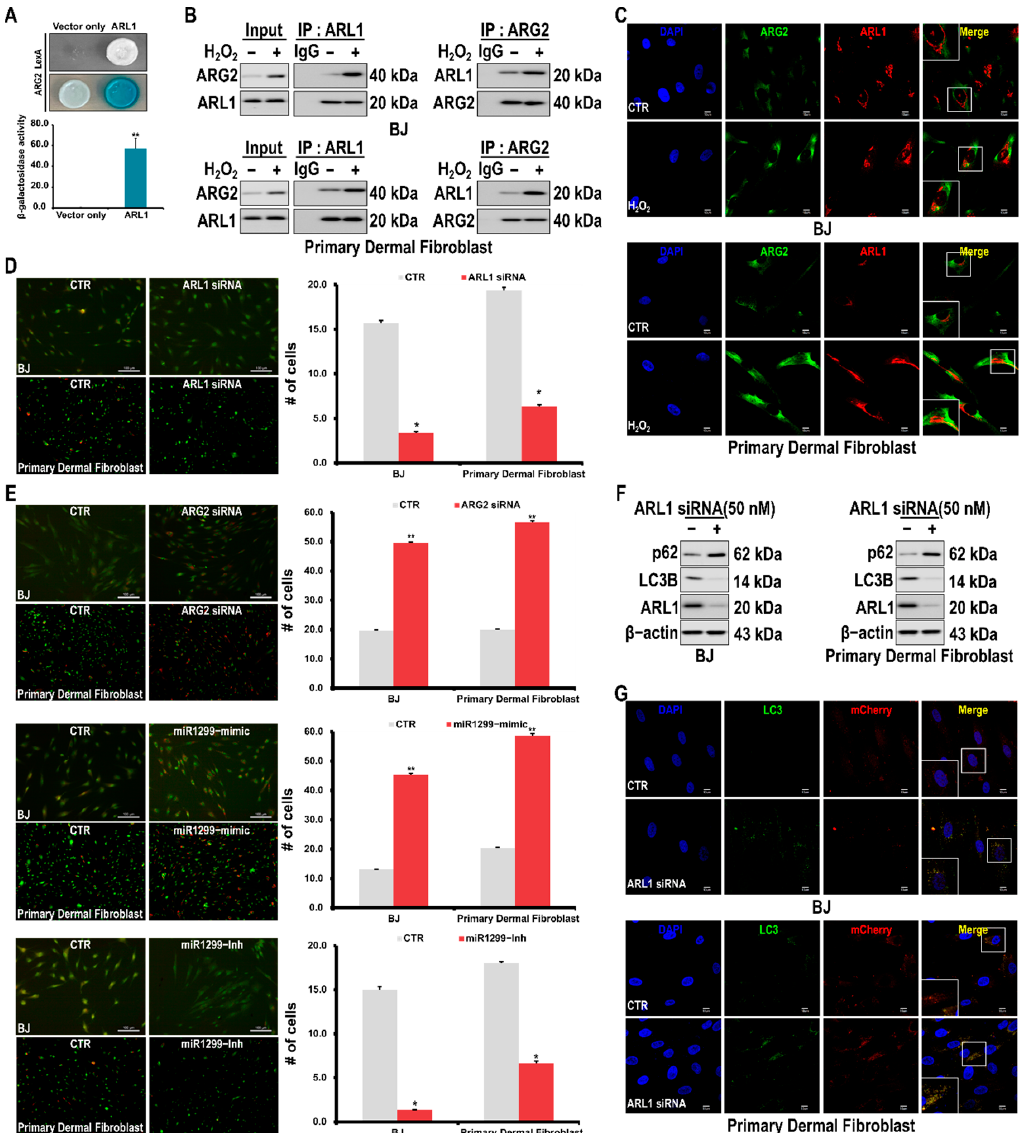
Figure 4. ARG2-induced senescence of skin fibroblasts through interaction with ARL1. ( A ) Yeast two-hybrid assay for ARG2 interaction with ARL1. ( B ) Co-immunoprecipitation of ARG2 with ARL1. Cells were treated with H 2 O 2 (200 µ M) for 24 h, and the interaction between ARG2 and ARL1 was examined by Western blotting. ( C ) Confocal microscopic analysis of ARG2 and ARL1 expression. Cells were treated with H 2 O 2 for 24 h and examined by confocal microscopy. DAPI staining was used to identify the nucleus. Bar, 10 mm. ( D ) Effects of ARL1 knockdown on autophagy in skin fibroblasts. Cells were stained with acridine orange and examined by fluorescence microscopy. ( E ) Effects of ARG2 knockdown (top), miR-1299 mimic (middle), and miR-1299 inhibitor (bottom) on autophagy in skin fibroblasts. Cells were stained with acridine orange and examined by fluorescence microscopy. # represents the number of senescent cells. ( F ) Effect of ARL1 knockdown on the expressions of the autophagy-related proteins, p62 and LC3B, in skin fibroblasts. Protein levels were determined using Western blotting. ( G ) Effect of ARL1 knockdown on the autophagic flux in skin fibroblasts. Cells were transfected with an ARL1 siRNA and then transfected the next day with an adenoviral vector harboring tandem fluorescent mCherry-GFP-LC3 on the next day. After 24 h, the cells were examined by confocal microscopy. DAPI staining was used to identify the nucleus. Bar, 10 mm. A * p value < 0.05 and ** p value < 0.01 were considered statistically significant and error bars represent ±